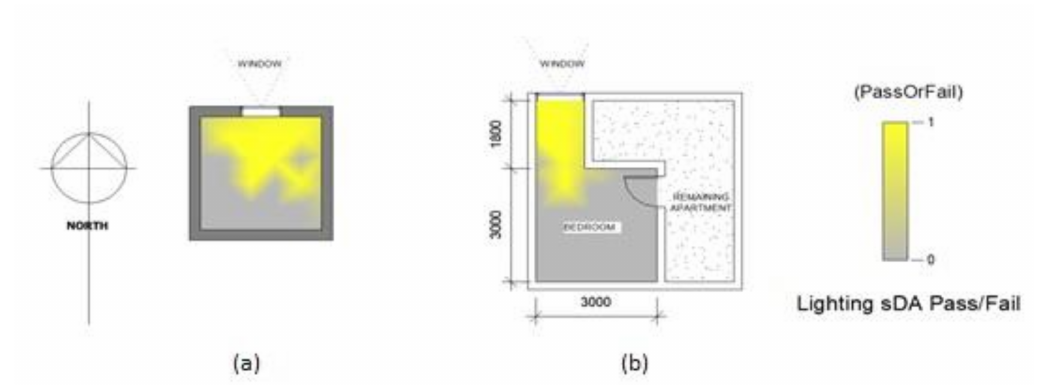
Figure 8. Light distribution as sDA in ( a ) standard layout ( b ) Snorkel